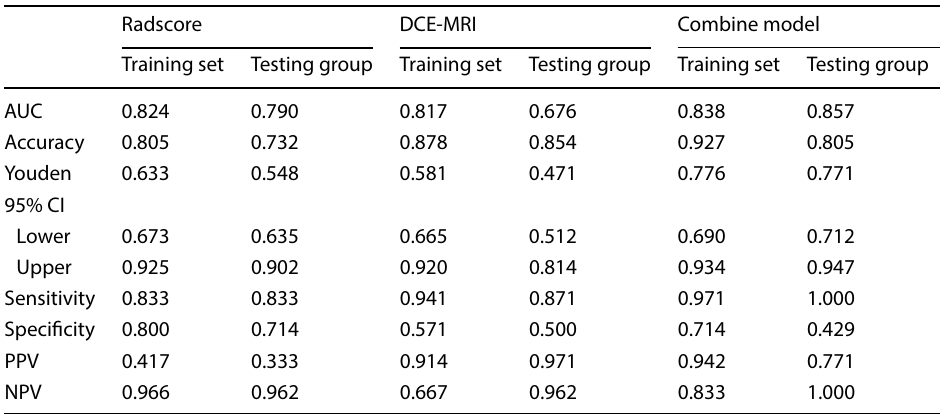
Table 2 Predictive ability of different